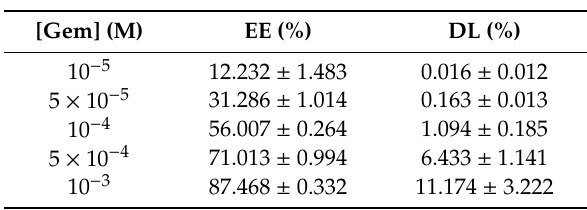
Table 3. Entrapment e ffi ciency ( EE , %) and loading ( DL , %) of Gem to the Fe 3 O 4 / PCL NPs (of 2:4 Fe 3 O 4 :PCL weight